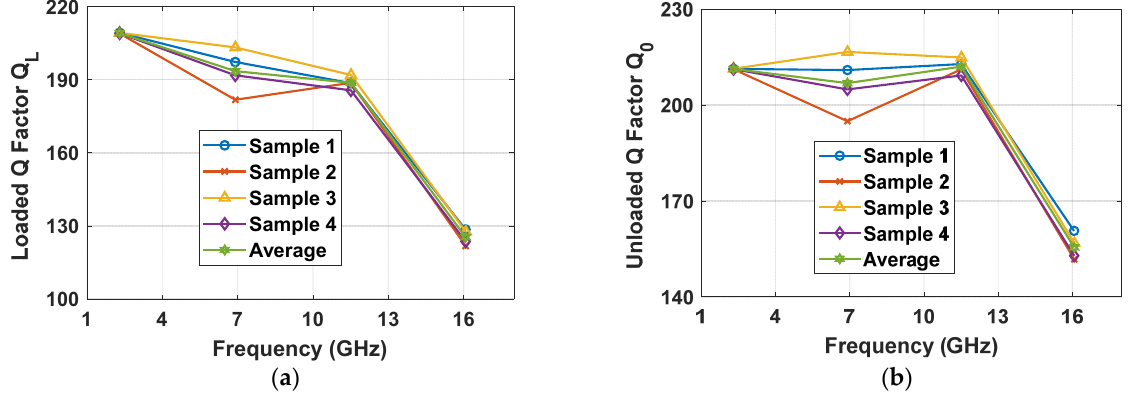
Figure 5. ( a ) The loaded quality factors and ( b ) the unloaded quality factors of the selected four samples. Figure 6a depicts the quality factors brought by various parts of sample 3, namely conductor quality factor Q c , radiation quality factor Q r , and dielectric quality factor Q d . Based on the quality factors described in Figure 6a, the dielectric loss tangent values calculated from the loaded and unloaded quality factors are shown in Figure 6b, from which we can observe that using the unloaded quality factor to achieve reliable dielectric results is of great importance. In addition, the differences of dielectric loss tangent values calculated from Q L and Q 0 at higher frequencies are larger, indicating that the measurement accuracy is lower if Q L is used for calculation. Figure 7 presents the derived dielectric loss tangent tan 𝛿 of these samples at various resonant frequencies. From the figure, we can see that the dielectric loss tangent increases slightly within the frequency range. The average tan 𝛿 of the substrate at resonance order 1 ( ~2.3 GHz ), order 3 ( ~6.9 GHz ), order 5 ( ~11.5 GHz ), and order 7 ( ~16.1 GHz ) are 9.286 (cid:3400) 10 (cid:2879)(cid:2872) , 3.4 (cid:3400) 10 (cid:2879)(cid:2871) , 3.1 (cid:3400) 10 (cid:2879)(cid:2871) , and 4.7 (cid:3400) 10 (cid:2879)(cid:2871) , respectively. The dielectric loss tan ‐ gent given on the datasheet at 1 GHz is 0.0009, while the measured value at order 1 ( ~2.3 GHz ) is 9.286 (cid:3400) 10 (cid:2879)(cid:2872) , which means a small deviation of 0.286 (cid:3400) 10 (cid:2879)(cid:2872) (relatively 3.18%) is observed. A comparison among different resonator ‐ based methods for dielectric characterization is presented in Table 2, including the applied technique for property ex ‐ traction ( Tech. ), the measured 𝜀 (cid:3045) / tan 𝛿 , the extraction accuracy when comparing with ref ‐ erence values ( ∆𝜀 (cid:3045) / ∆tan 𝛿 ), the unloaded quality factor ( 𝑄 (cid:2868) ), the working frequency ( Fre. ), and the processibility of the method ( Proc. ). It can be seen from the table that the proposed UGCPW embedded resonator method possesses very high extraction accuracy for deriv ‐ ing dielectric properties of microwave substrates, and the value of the unloaded quality factor is larger than that based on ML or CPW transmission line methods in the literature. Though SIW resonator method could achieve a higher quality factor and working fre ‐ quency, it requires metal via operations on the substrate under test, which makes it not suitable for dielectric characterization of some newly developed materials with the diffi ‐ culty of realizing metal via holes.